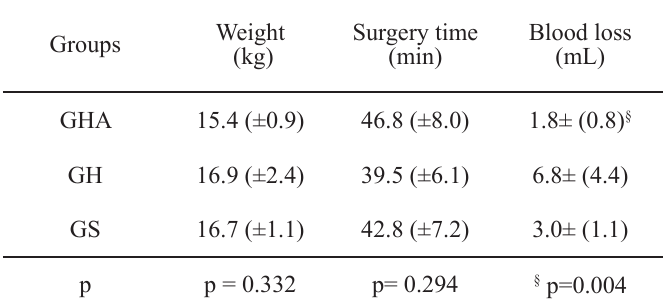
TABLE 2 - Distribution (means and standard deviation)